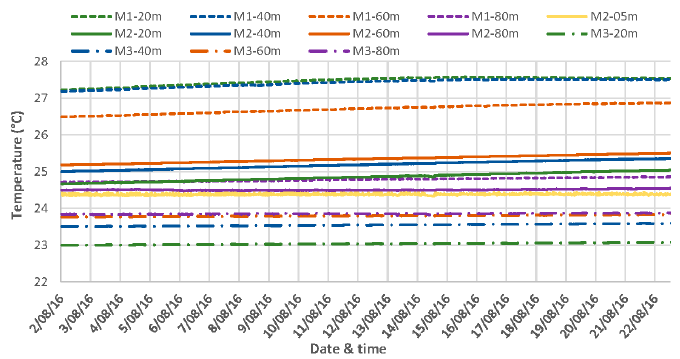
Figure 8. Monitoring boreholes (M1, M2, M3) temperatures of DX system with different depths as indicated from August 1 to August 22, 2016.